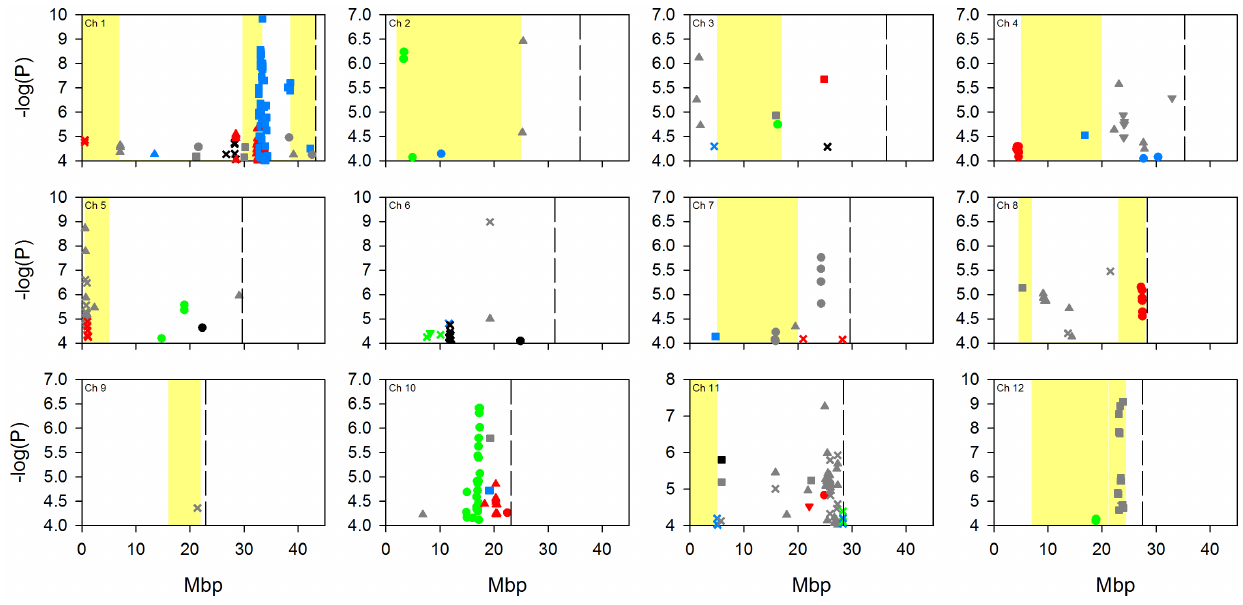
Figure 2. GWA mapping of copper concentration at the five field sites across the 12 rice chromosomes. Data points represent SNPs significantly associated (p , 0.0001) with the trait and which have a MAF . 5%. Significant SNPs from different experiments are displayed with different coloured symbols: 2006 Arkansas are red, 2007 Arkansas are black, 2009 Texas are blue, Faridpur are green, and Qiyang are grey. Analyses of the combined subpopulation groups and separate subpopulations are represented by different symbols: combined analysis=X, aus =circle, indica =square, tropical japonica =triangle, temperate japonica =inverted triangle. Yellow highlighted bars indicate regions of mapped QTLs for grain copper concentration (17, 21, 22). Dotted lines indicate chromosome ends. doi:10.1371/journal.pone.0089685.g002 This QTL for copper was previously detected in the population of The significant SNPs which were associated with grain TeQing-into-Lemont introgression lines (TILs; [22]). molybdenum were in the same genomic region as a previously